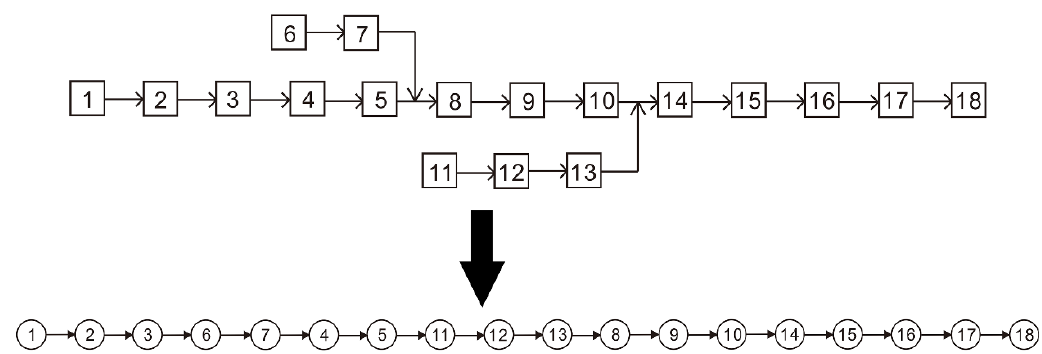
Figure 4. Example of coding operation.